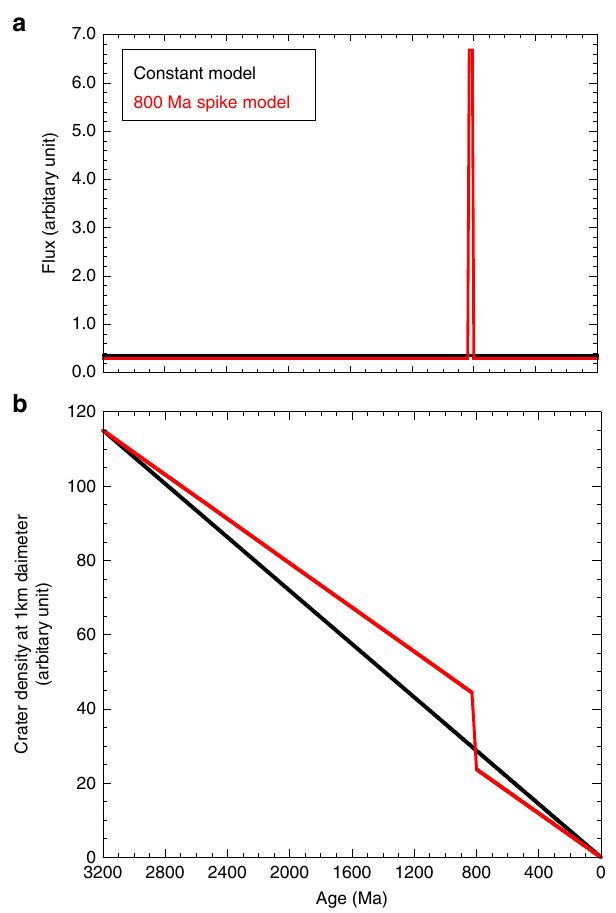
Fig. 5 Two fl ux models and their cumulative curves of crater numbers with time. a illustrates a conventional constant model and an 800 Ma spike model, and b illustrates their cumulative curves of crater numbers as a function of time, where total counts of craters older than 3.2 billion years are adjusted to be the same in both models.